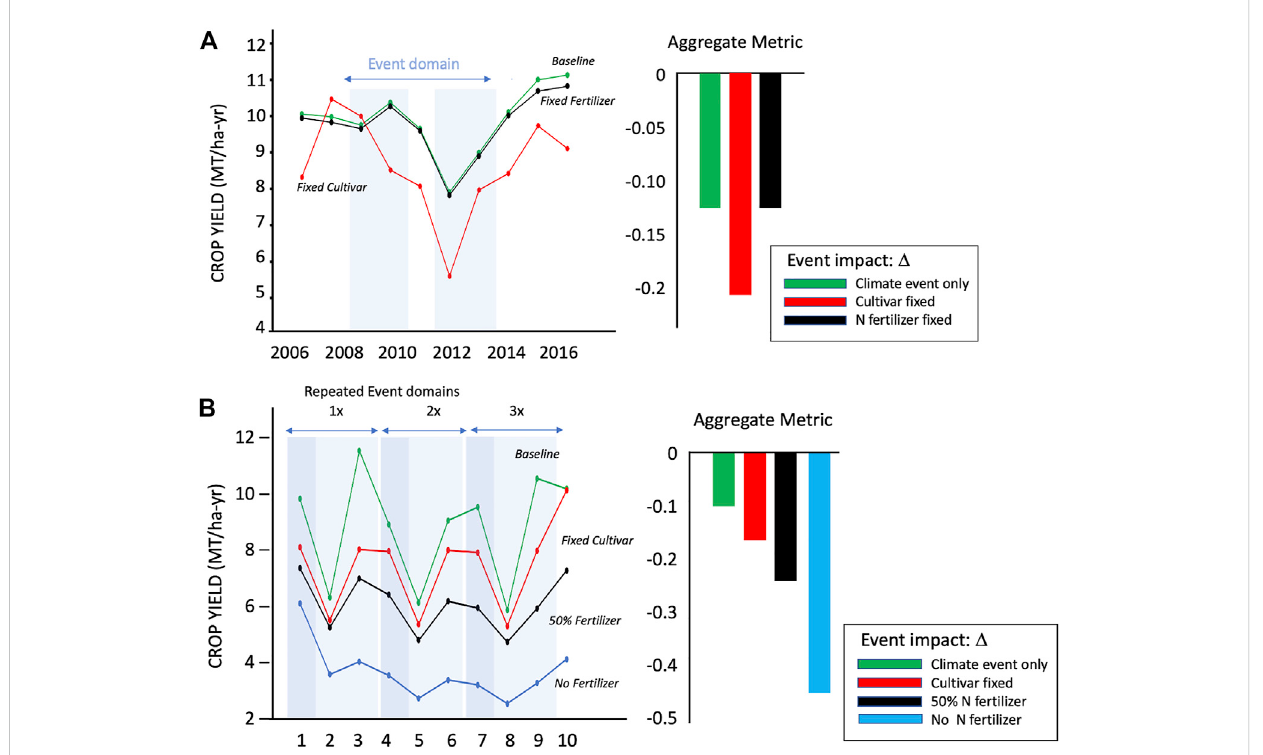
FIGURE 3 (A) .Model simulationtimeseries,showingBaseline,ascenarioremovingcultivardevelopment ( fi xedat1980slevels),andanexperiment removingN fertilizer(also fi xedat1980s)simulatingtheMWdroughtof2011 – 12usingclimateexperimentApproach (A) ( left )CornyieldintheMWfrom2007to2016, and ( right ) Drought impact metrics (Eqs. 1, 2) expressed as bar graphs (B) . Climate Approach B experiments showing progressive impacts of repeated drought, loss of cultivars and N fertilization rates. The climate event Δ was computed using the climate-related variant of Eq. 3; all other Δ metric values are computed using the MFE variant, as explained in Section 2.3 and shown on the vertical axes to the